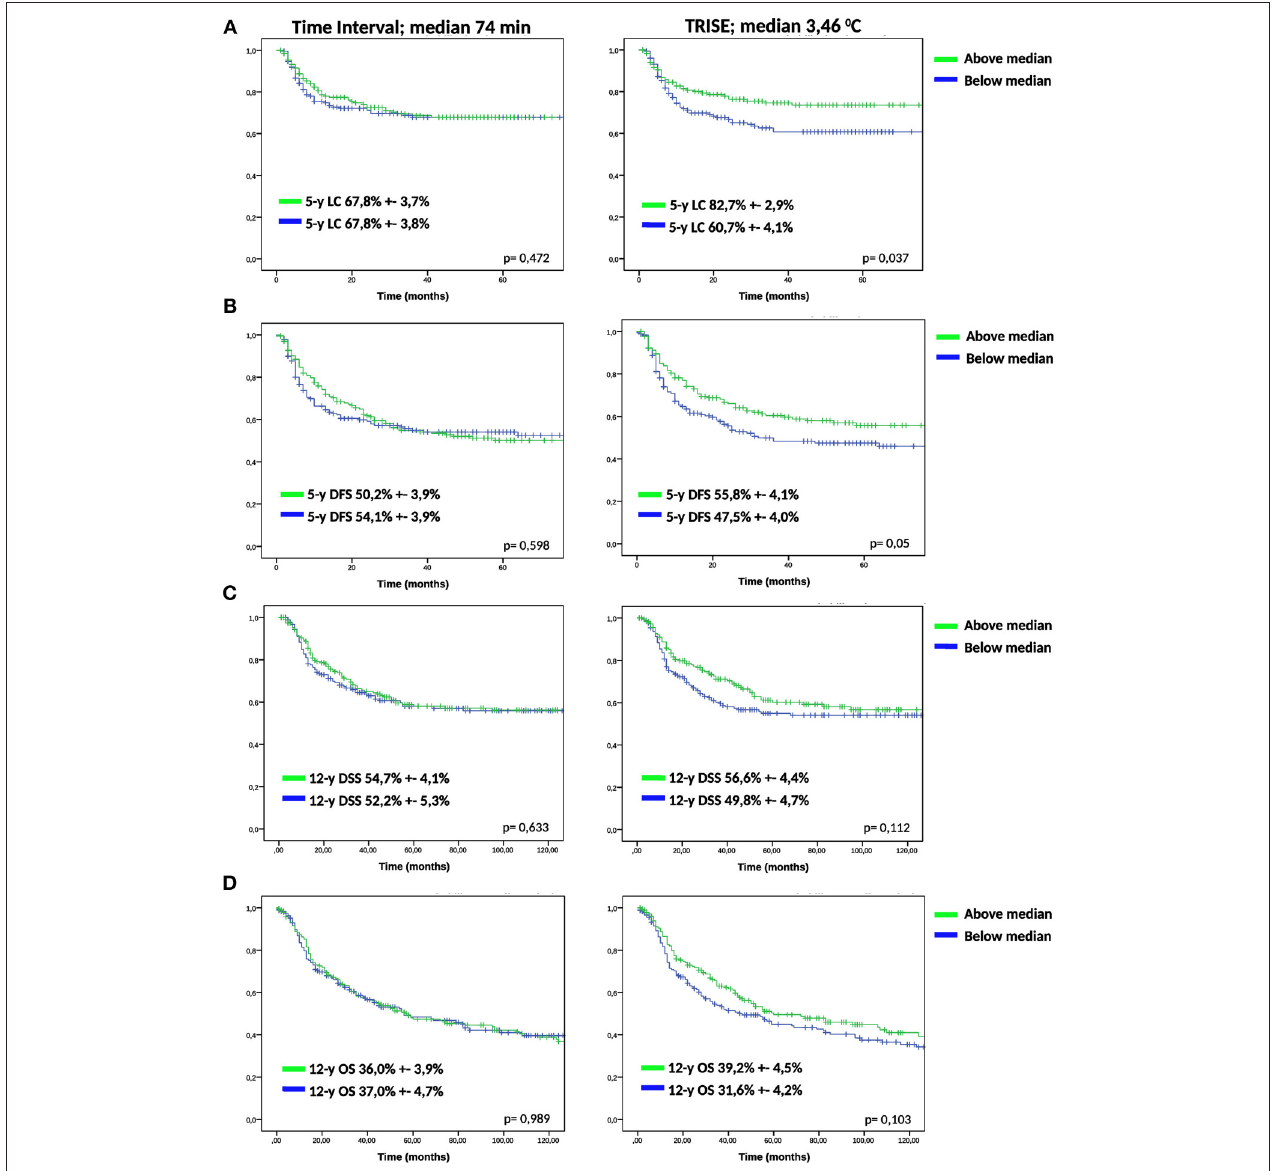
FIGURE 1 | KM analysis of low and high time interval and TRISE. KM-curves for low and high time interval and TRISE for LC (A) , DFS (B) , DSS (C) , and OS (D) were compared using log-rank